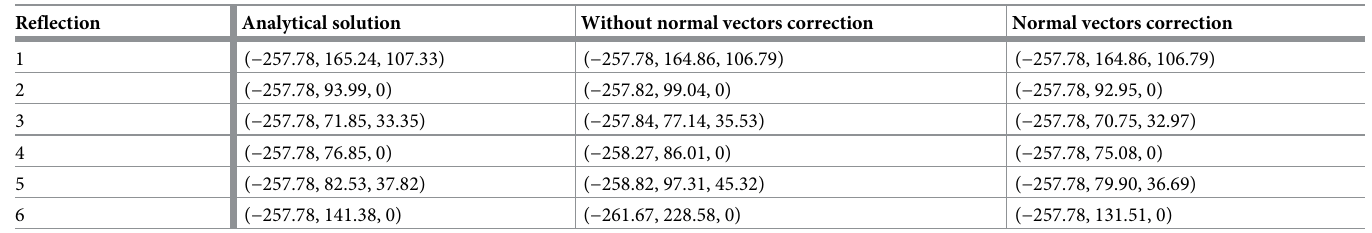
Table 2. The coordinates of each hit point under multiple reflections.